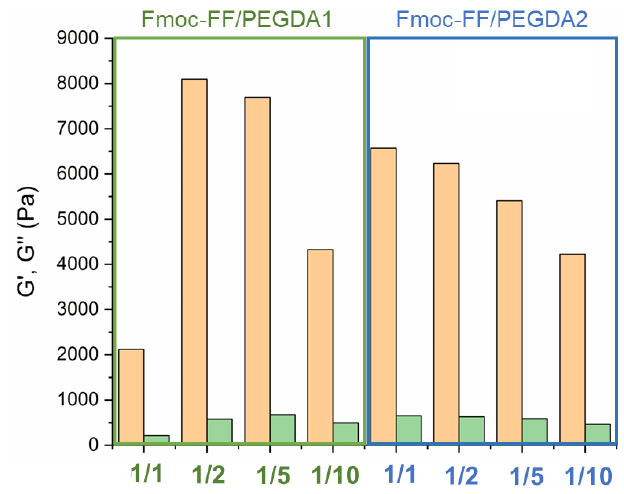
Figure 9. Rheological bar plots of 0.5 wt% mixed HGs. Plot reports both G’ (orange bar) and G” (green bar) moduli of each time sweep experiment (20 min, strain of 0.1%, frequency 1 Hz). Values are expressed on the Pascal (Pa) logarithmic scale.